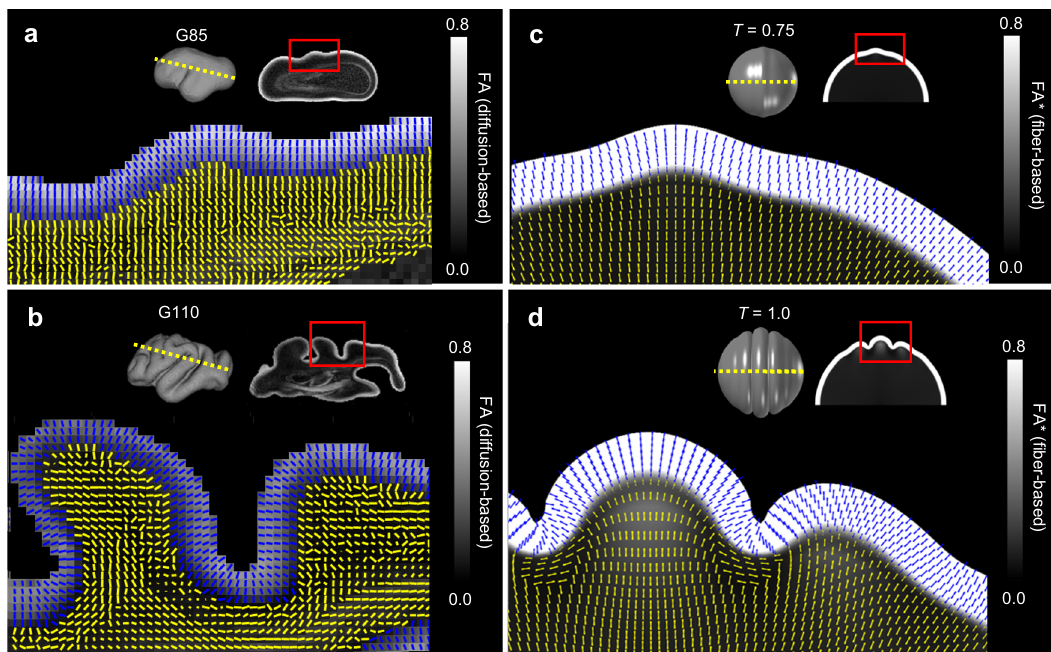
Fig. 4 Anisotropy in the developing subplate matches model predictions. a – b Primary eigenvector directions (tick marks) based on high-resolution DTI of the rhesus macaque ( Macaca mulatta ) brain at G85 ( a ) and G110 ( b ), at the slice indicated by the yellow dotted line and location indicated by the red box. Tick marks that appear as dots, rather than lines, indicate primary eigenvector direction that is out of plane (pointing into the page). Fractional anisotropy (FA) maps are shown as an underlay. c – d Primary eigenvector directions (tick marks) based on the fi ber volume fractions predicted by model at the onset of folding ( c ) and after fold formation ( d ). FA* maps based on the 3D tensor describing model subplate volume fractions are shown as an underlay, with cortical FA* (not de fi ned in model) set to 1 for visualization. Tick marks are colored such that blue = cortex and yellow = subplate and deeper subcortical layers. T = nondimensionalized simulation time. Data are presented for the only G85 hemisphere, and for one representative hemisphere of three G110 hemispheres investigated in this